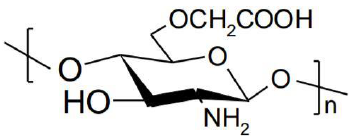
Figure 5. Chemical structure of O -carboxymethyl chitosan.